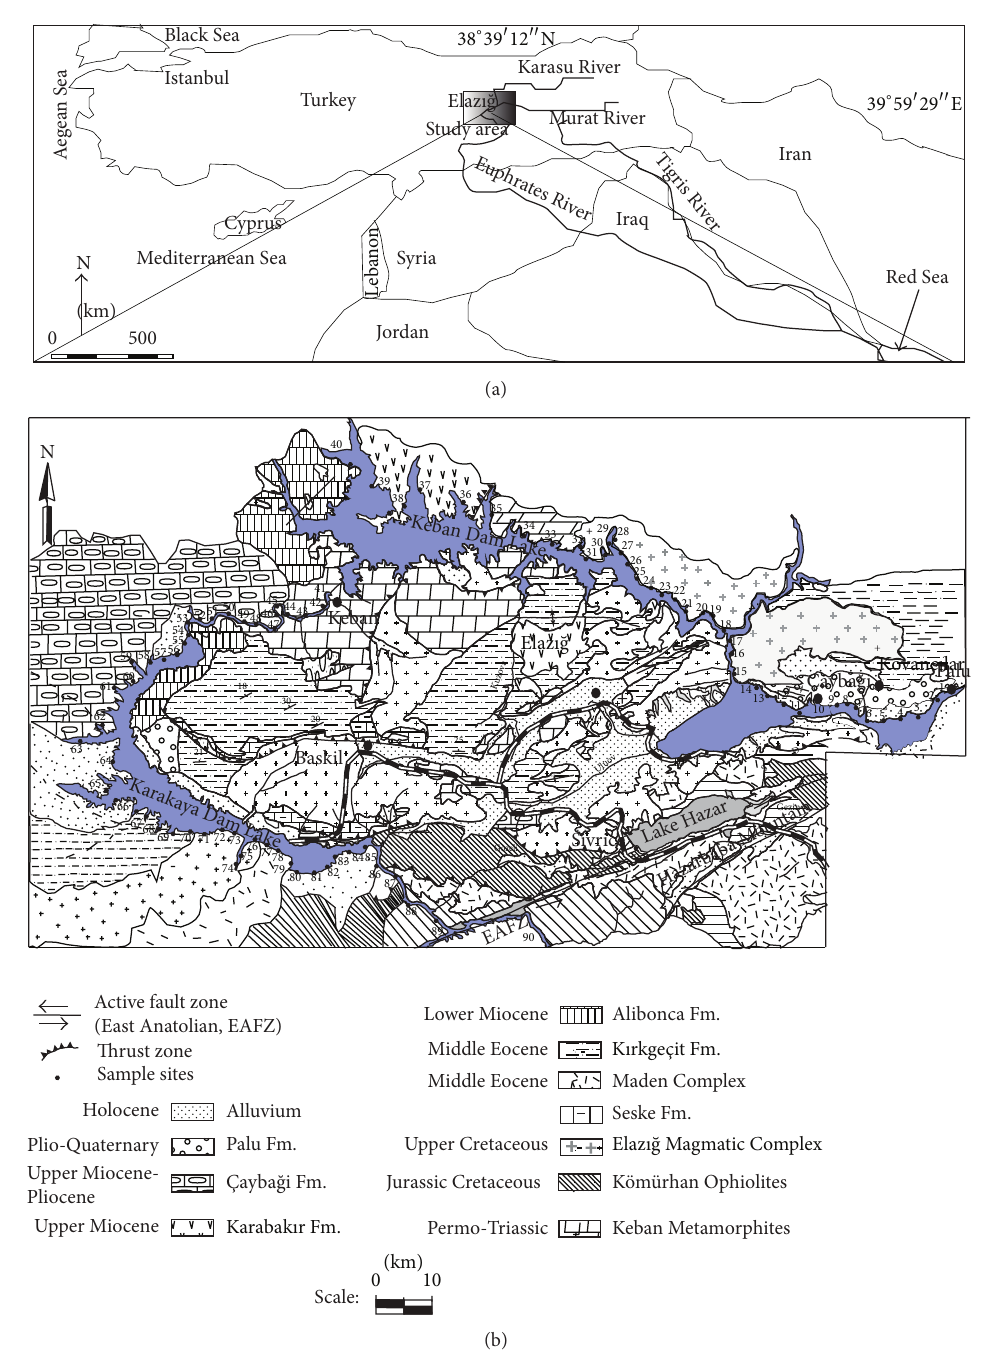
Figure 1: (a) Location map. (b) Geology map of the Euphrates River and the sampling sites (from 1 to 90, the geology map was modified from Herece et al.